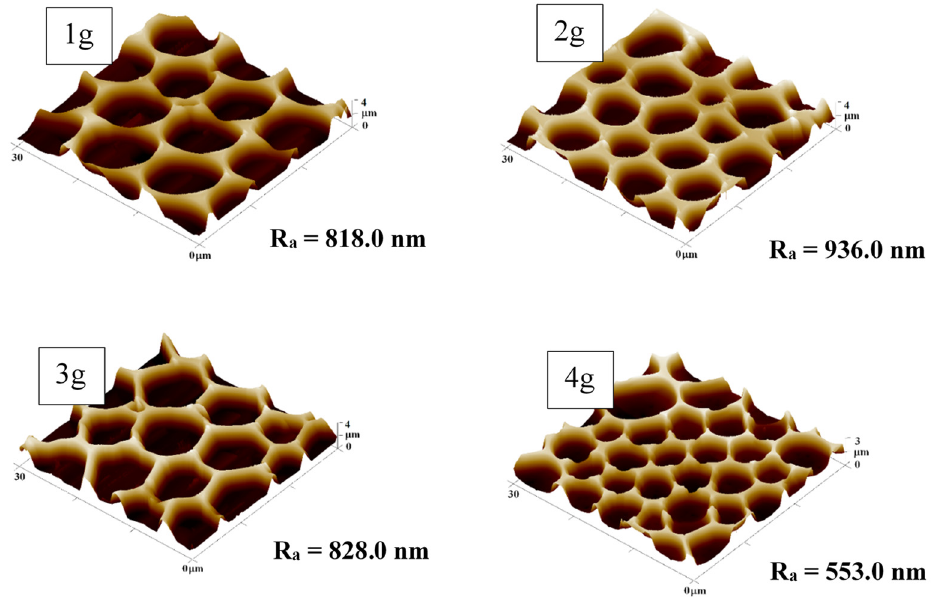
Figure 2. The surface morphology of honeycomb-like pattern minor areas on plasma-modified fluorinated ethylene propylene with different amounts (1–4 g) of incorporated polymethyl methacrylate. The scanned areas were 30 × 30 µm 2 . R a represents the average roughness in nm.